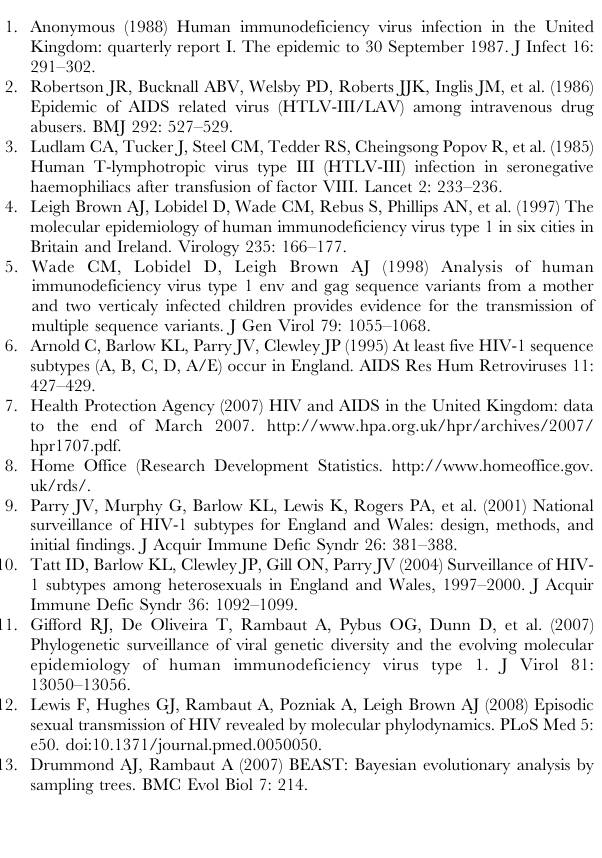
Figure S8 Time-scaled phylogenies of other non-B subtype clusters of size $ 10 with terminal branches removed. Red nodes indicate UK transmission clusters as defined against analysis with global diversity. Black/grey nodes indicate where terminal branches have been removed. The scale bar is in calendar years. Figure S9 Histograms of CD4 counts by HIV subtype. (A–D) Distribution of first available CD4 count (‘‘Diagnosis’’) by subtype. (E–H) Distribution of CD4 count at first treatment (Treatment’’) by subtype. (I–L) Distribution of CD4 count at treatment after correction by subtype. (M–N) Combined distributions at diagnosis (M) and first treatment (N). Figure S10 Recruitment to the UK HIV Drug